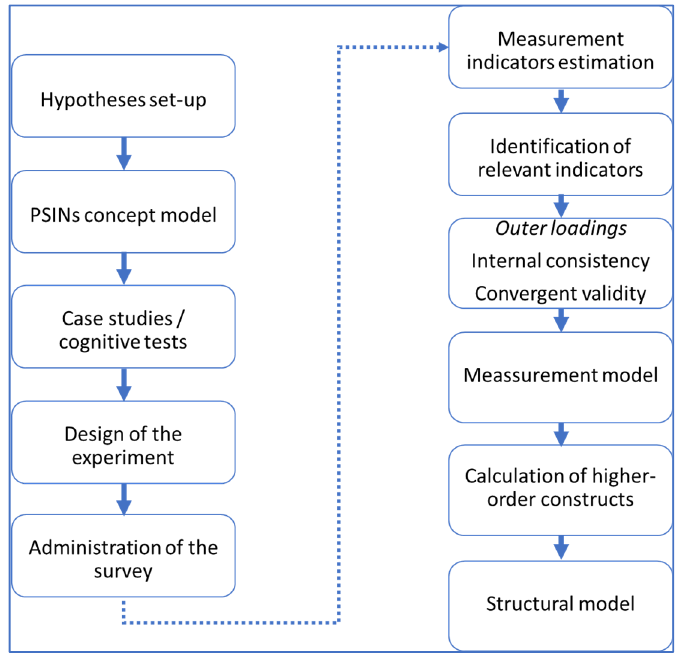
Figure 2. Exploration steps for our structural model validation (based on [30,55]).